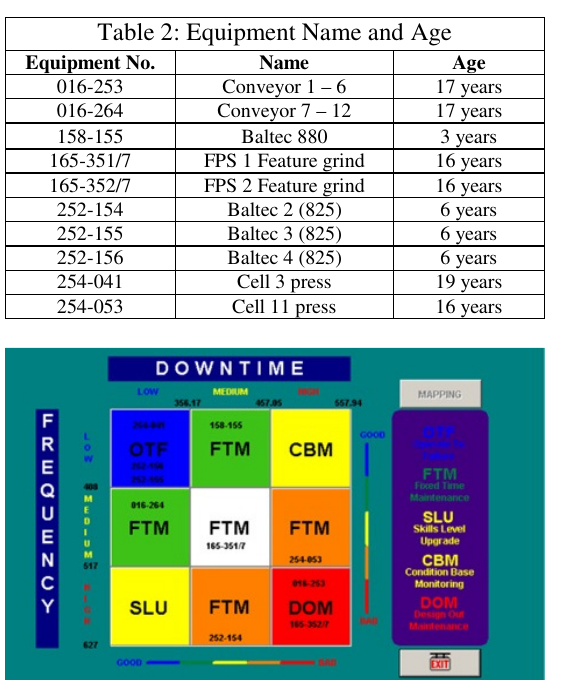
Fig. 2: Placement of machines in the Decision- Making Grid